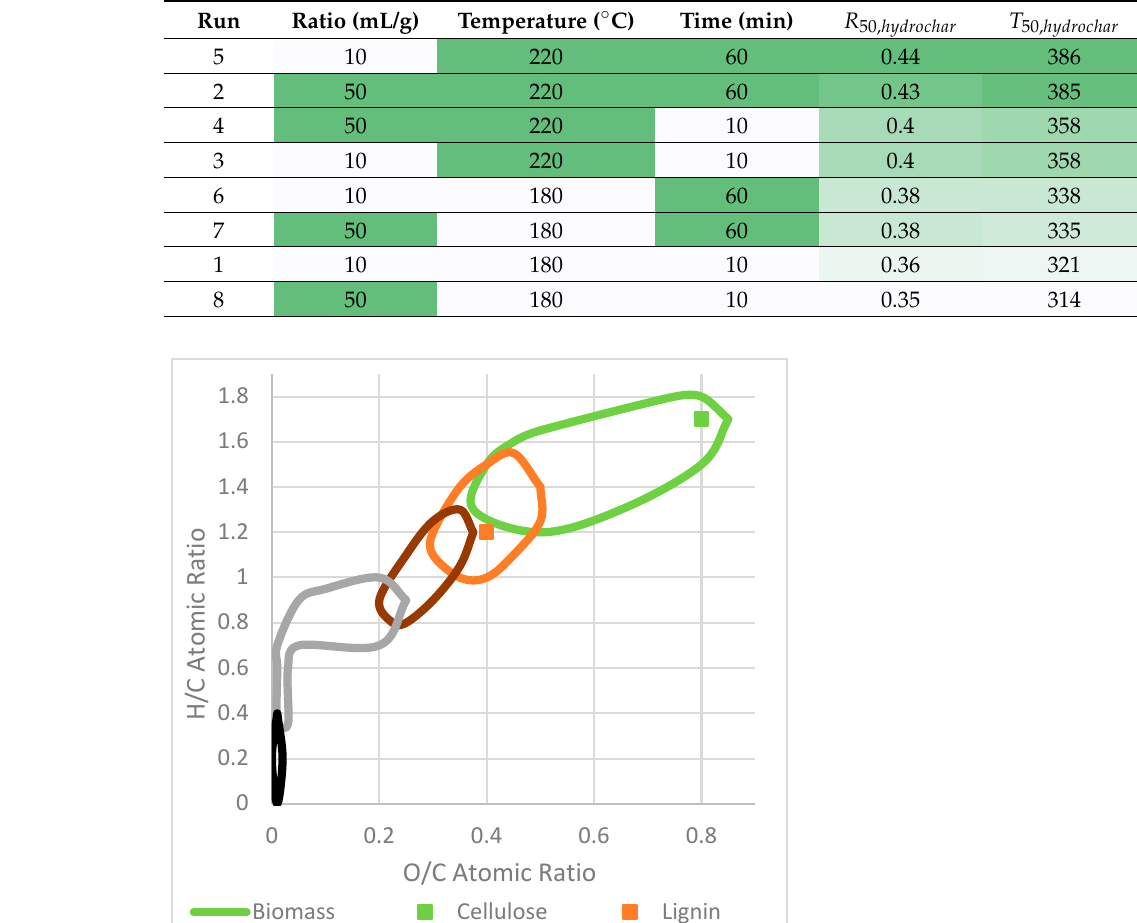
Table A4. Recalcitrance values of HC produced at different conditions.